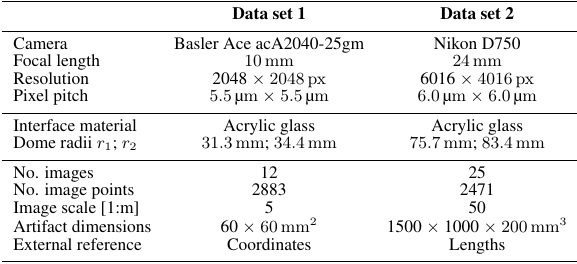
Table 2. Relevant setup parameters for both evaluated data sets